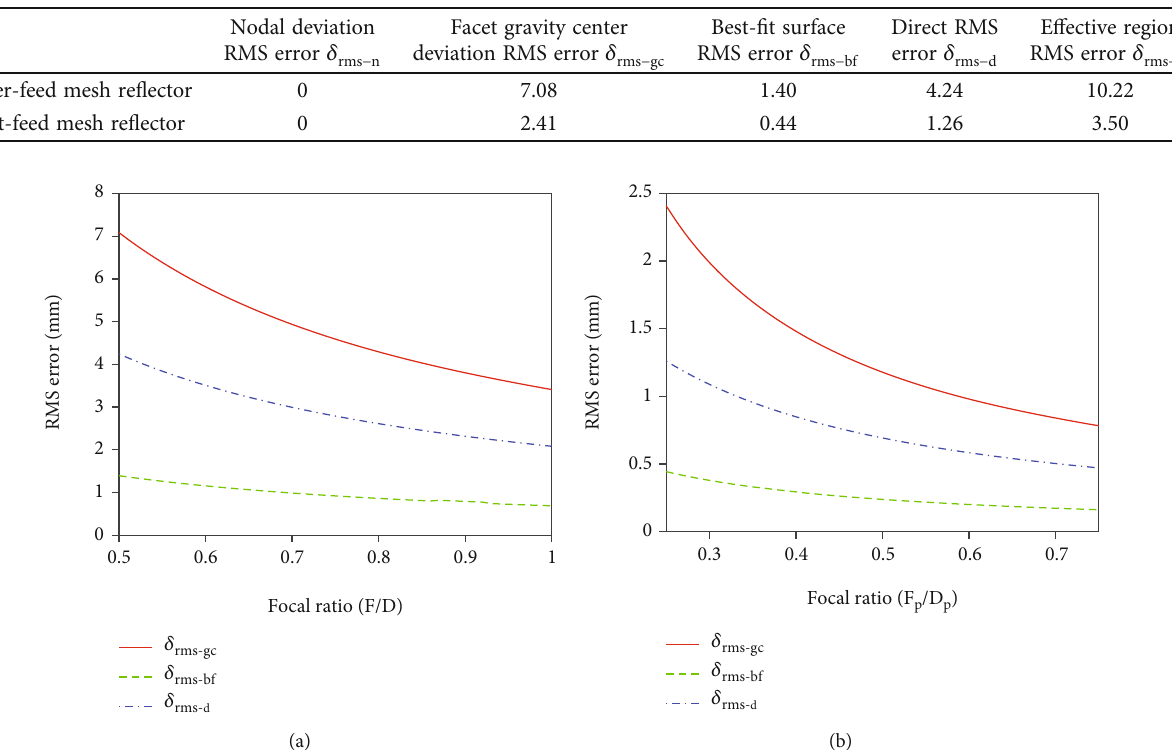
Figure 17: Comparison of RMS errors as the focal ratio increases for (a) the center-feed mesh re fl ector and (b) the o ff set-feed mesh re fl